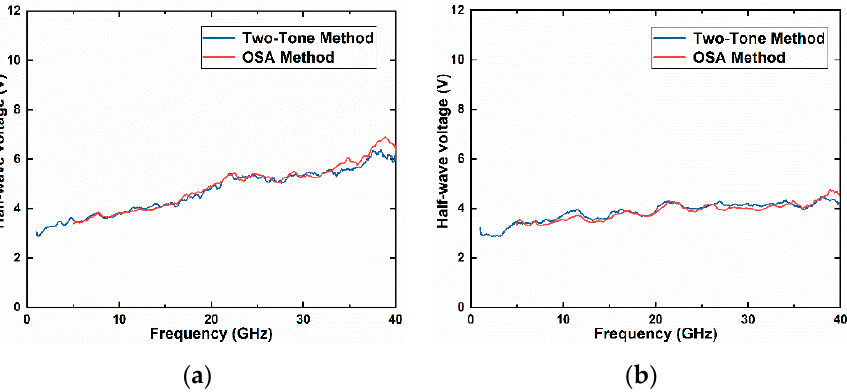
Figure 3. Half-wave voltages of ( a ) the PM and ( b ) the MZM at different modulation frequencies.